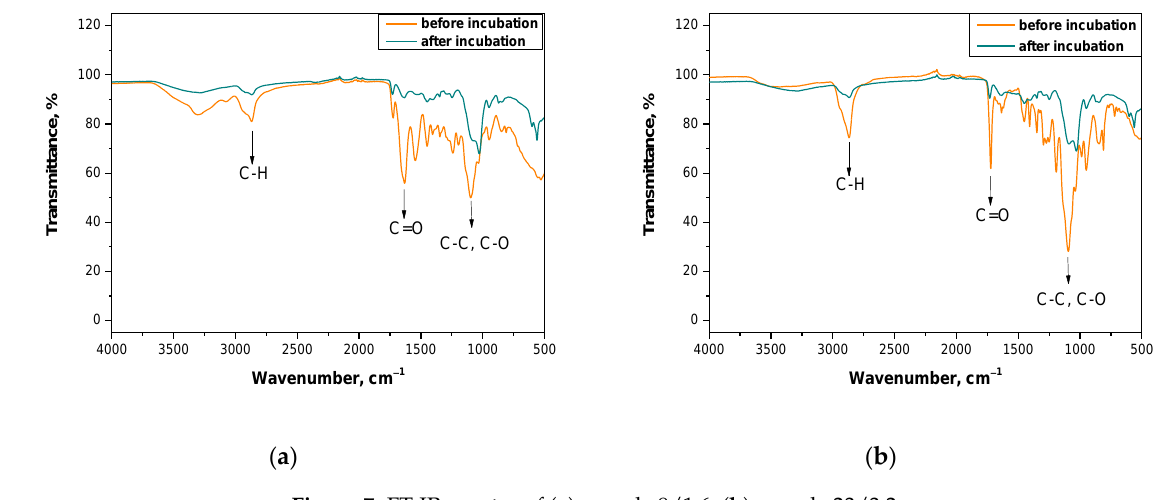
Figure 7. FT-IR spectra of ( a ) sample 9/1.6; ( b ) sample 23/3.2.